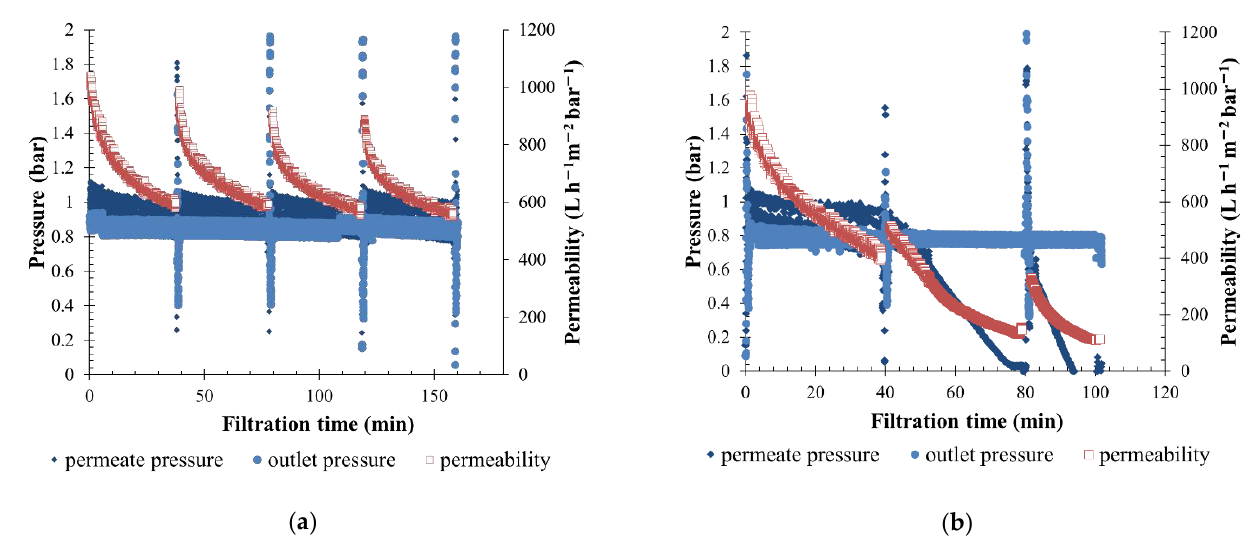
Figure 3. Variation of permeate pressure, outlet pressure and permeability value measured through- out the filtration time for ( a ) low-fouling water type, APL-SINGAPURA ME —J150—Rw = 79%; and ( b ) high-fouling water, CC-KERGUELEN J150 — Rw = 90%.1 BW 5 s/40 min; T = 20 °C; SiC membrane 0.33 m 2 .